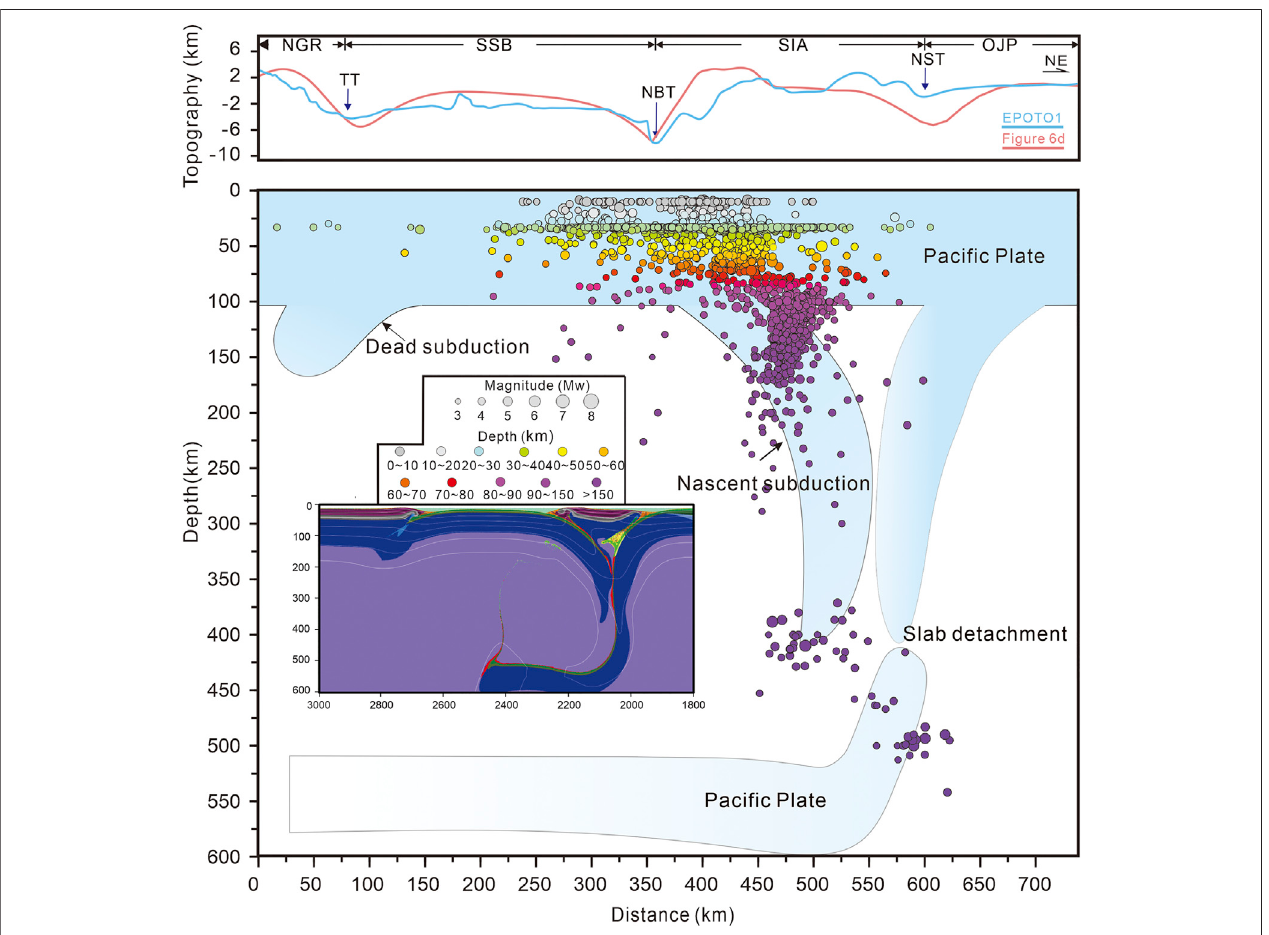
FIGURE 8 | Model results versus natural data. The topographic data in the abovementioned fi gure are from ETOPO1, and the seismic data in the lower fi gure are from Geomap (http://www.geomapapp.org). The sampling line is shown by red lines in Figure 1A .